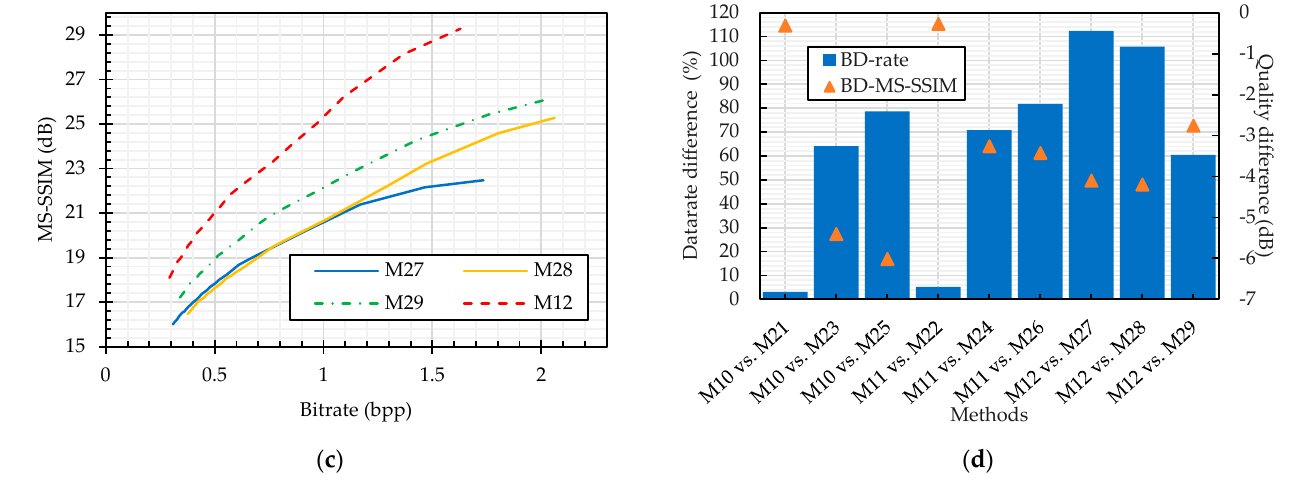
Figure 17. The sub-block size analysis in the IIB–CPE methods. In ( a , b ), the compression was carried out without chroma subsampling in the RGB and YCbCr colorspaces, respectively. ( c ) The compression was carried out with chroma subsampling. ( d ) The BD-measures plot.